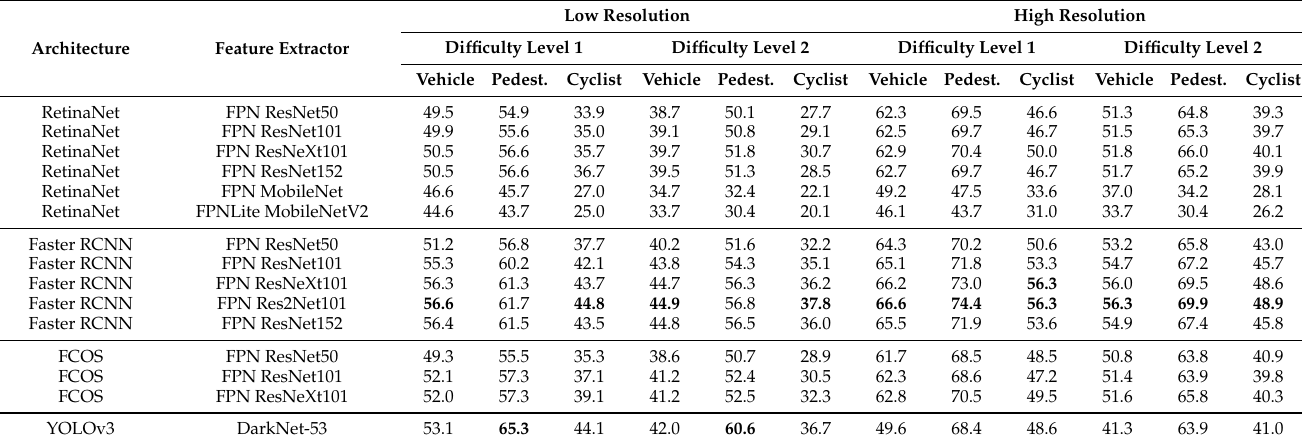
Table 6. Waymo per-class precision metrics with two different detection difficulty levels. Results are provided for low and high-resolution models. The best results are highlighted in bold.